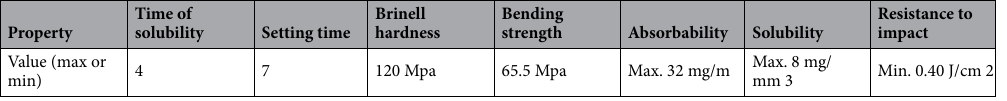
Table 1. The physical and mechanical properties of neat